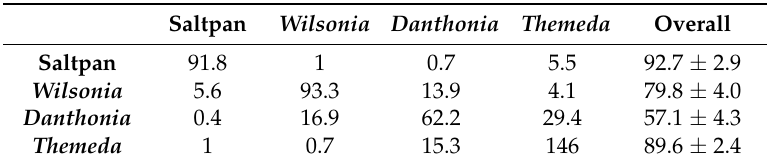
Table A6. Mean confusion matrix for reduced HSR four-class classification results. Confusion values are given as a count value, and overall accuracies as a percentage with standard deviation.